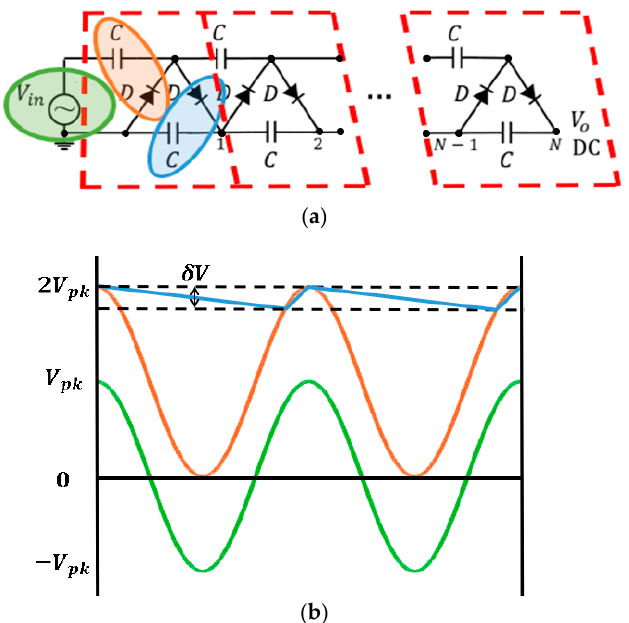
Figure 12. N -stage half-wave Cockcroft-Walton multiplier ( a ) and its working principle ( b ).